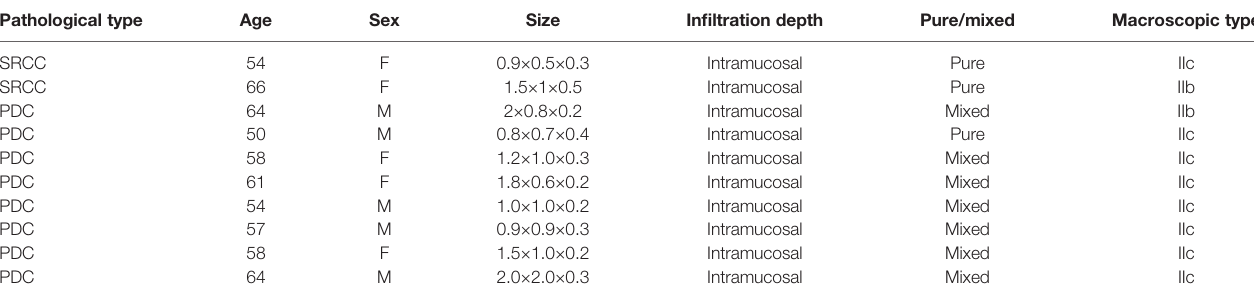
TABLE 8 | Pathological characteristics of cancers with ESD indication but with lymph node metastasis. Pathological